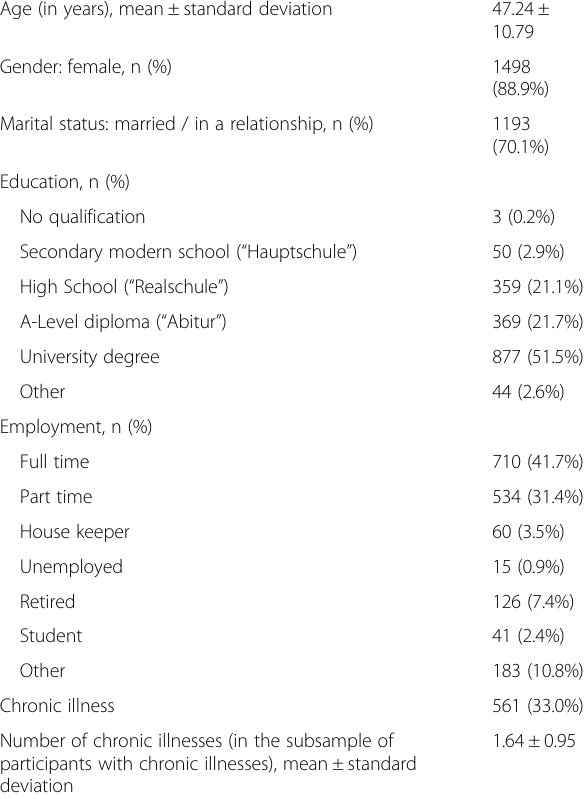
Table 1 Sociodemographic characteristics of